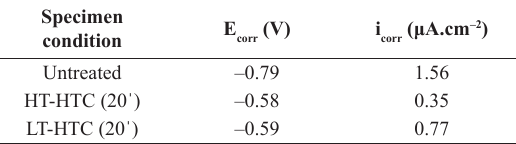
Table 2. Effect of HTC coating on corrosion potential (E corrosion current density